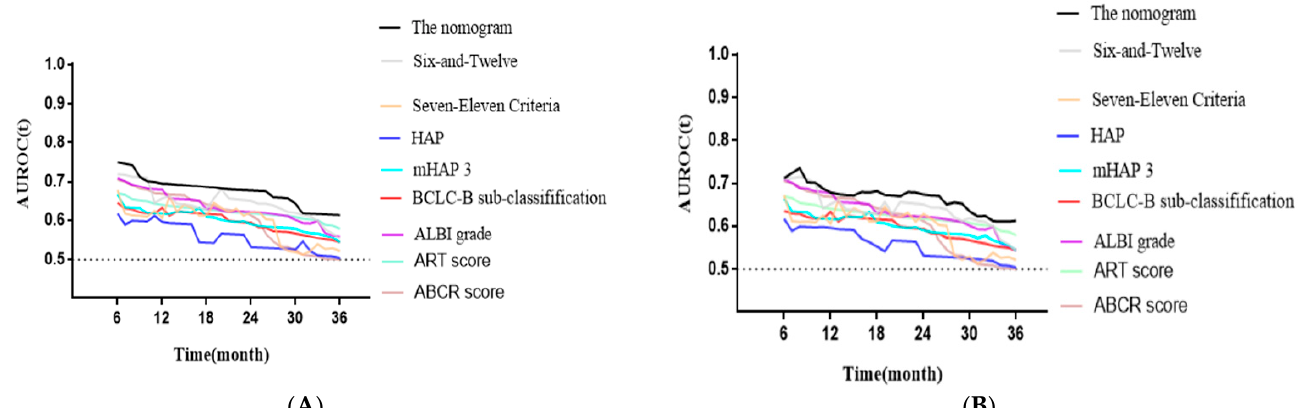
Figure 5. Time ‐ dependent AUROC values of the current model and other available models. ( A ): Figure 5. Time-dependent AUROC values of the current model and other available Time ‐ dependent AUROC values in training set. ( B ): Time ‐ dependent AUROC values in validation